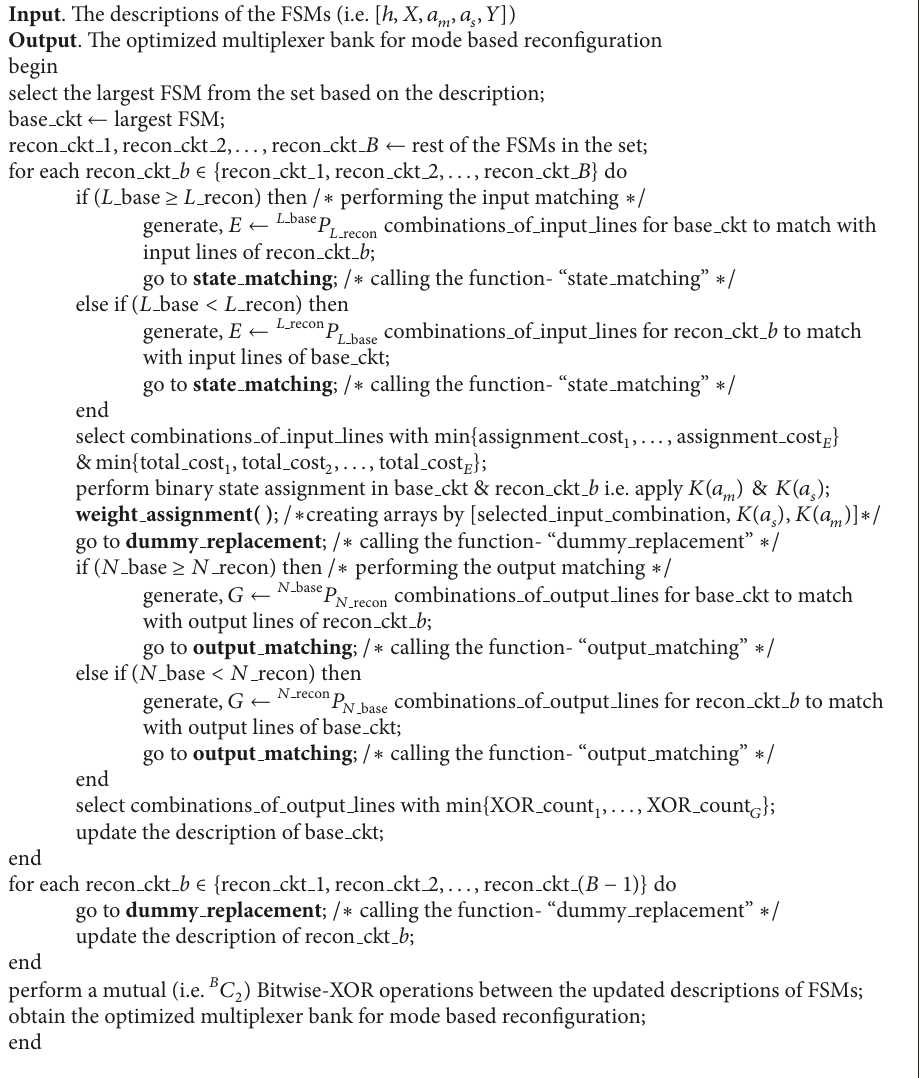
Algorithm 1: Iterative greedy heuristic based Hungarian